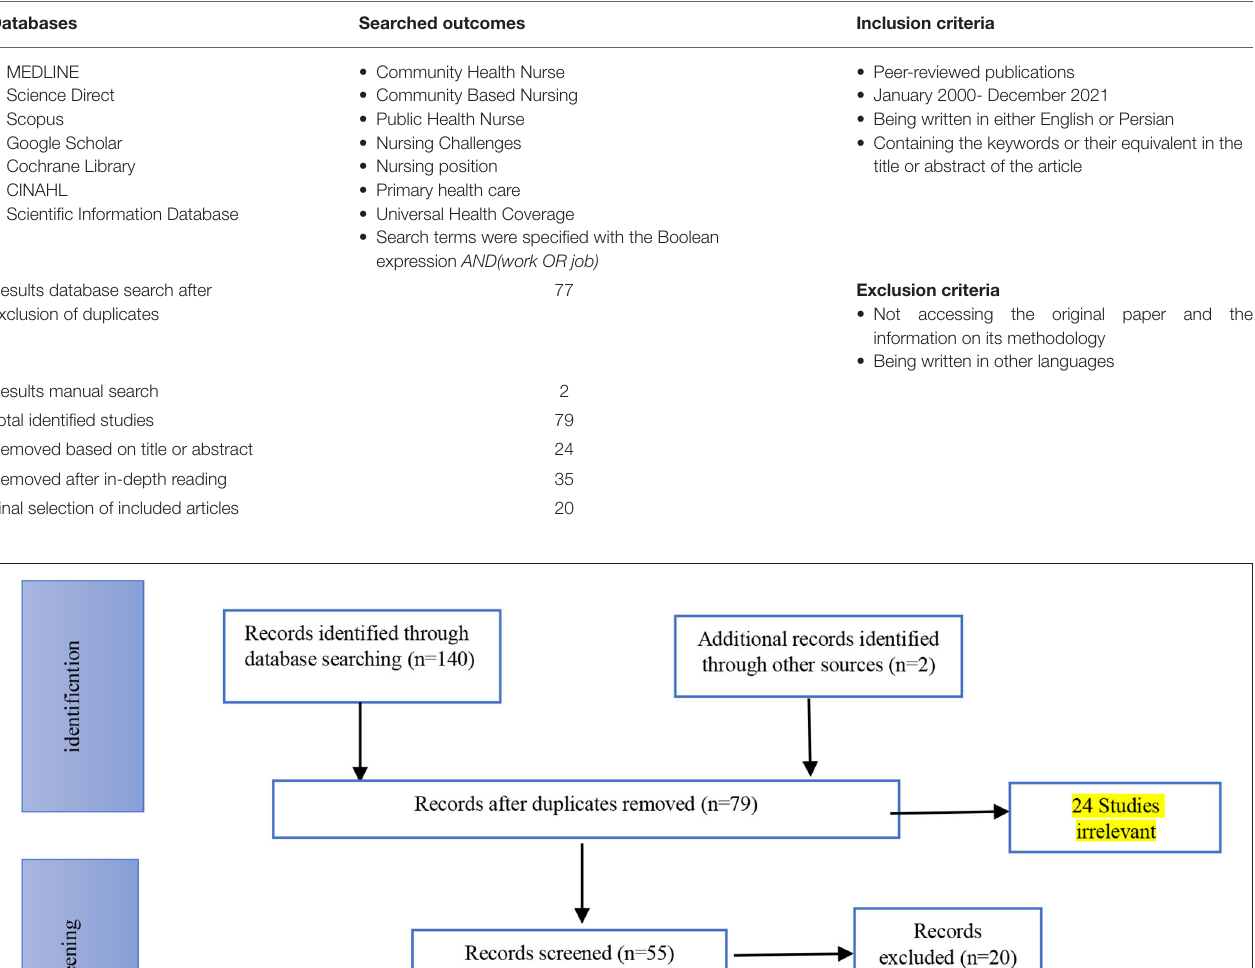
TABLE 1 | Search strategy.